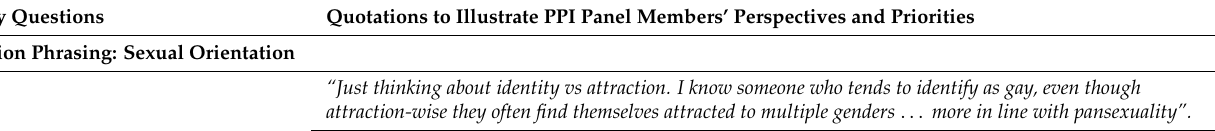
Table 4. PPI Panel members’ reflections on research validity and SOGI survey